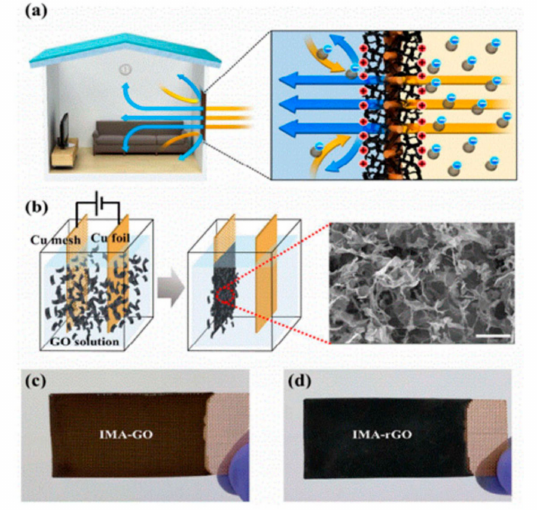
Figure 5. PM 2.5 removal mechanism, fabrication process, and the structure of reduced graphene